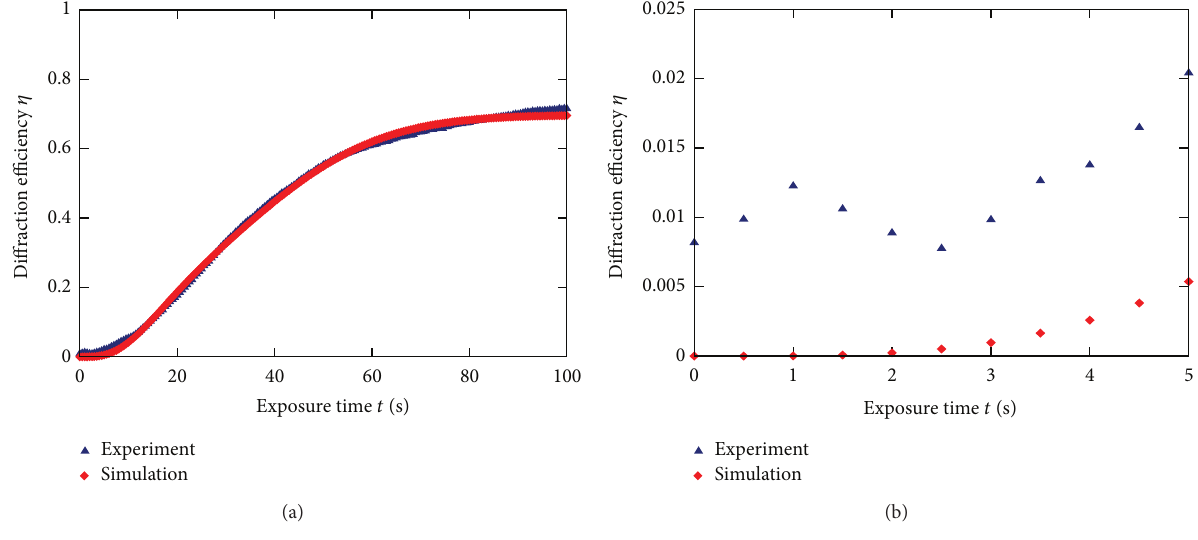
Figure 6: Time variation of diffraction efficiency.